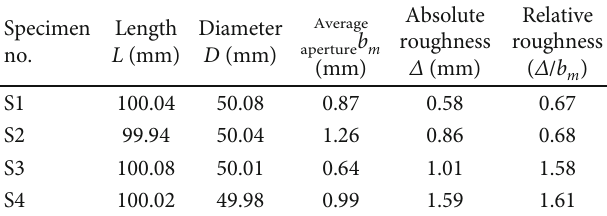
Table 1: Geometric parameters of the rough fractures. Specimen no.